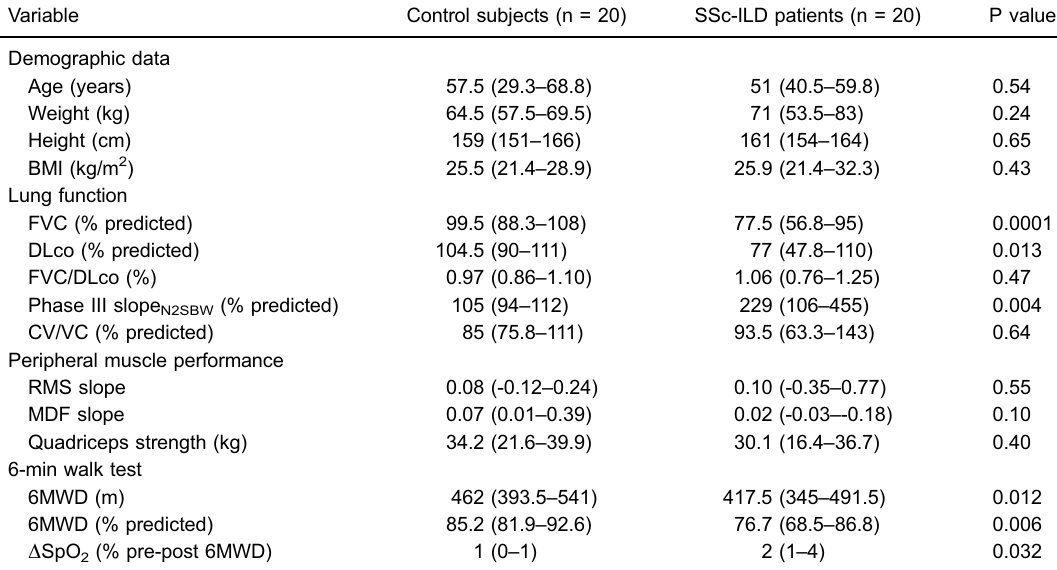
Table 1. Demographic data, lung function, physical function, peripheral muscle performance, and functional capacity of control subjects and systemic sclerosis-associated interstitial lung disease patients